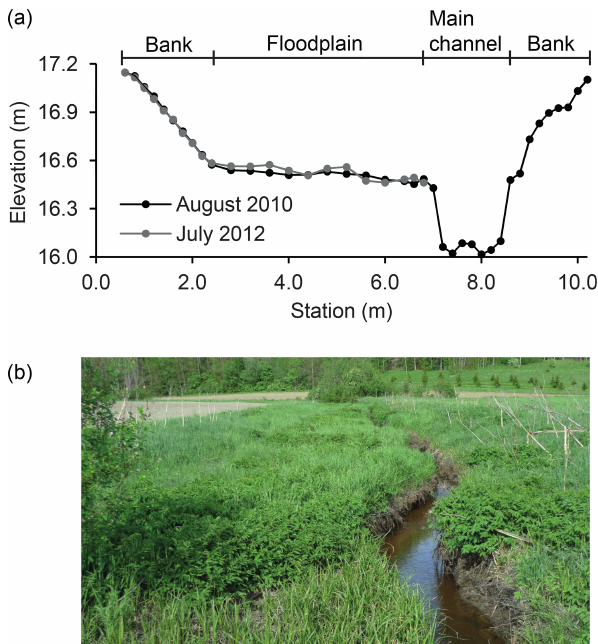
study (spring 2012): (a) GTLM, (b) STLM, (c) PTLM; the flume data set, case 2: (d) Pasche, (e) Mertens, (f) DCM. Confidence in- tervals and the median of the probabilistic solution are given with dashed lines; red line denotes the best simulation in the Monte Carlo ensemble. Observation points used for parameter identification are marked with squares ( (cid:3) ), while verification data points are marked with circles ( ◦